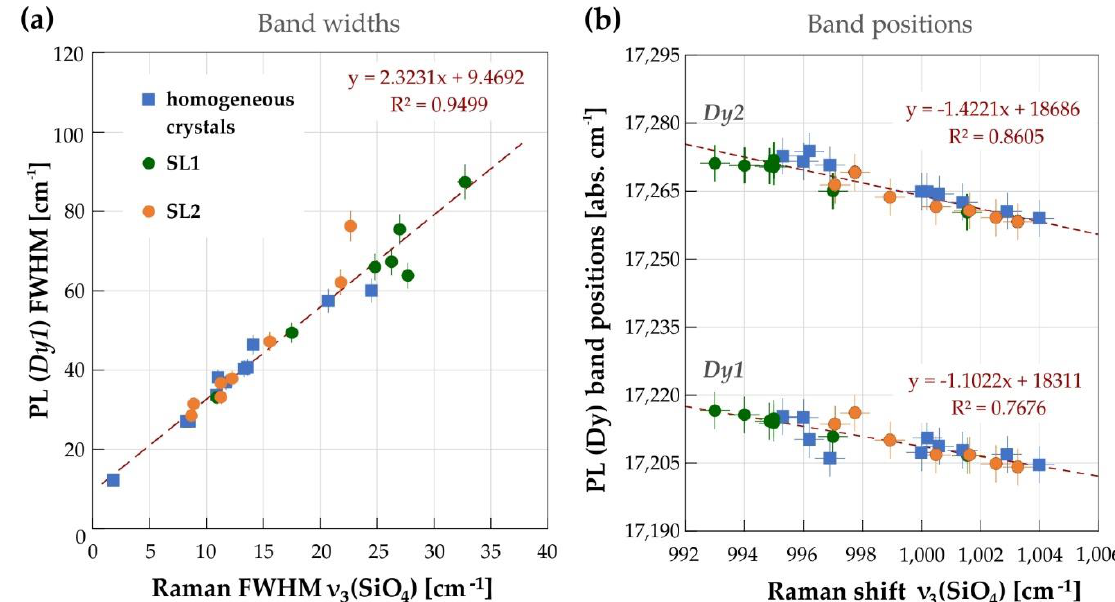
Figure 6. Comparison of spectral parameters of the Raman ν 3 (SiO 4 ) and laser-induced Dy 3 + photoluminescence sublevel-bands of Sri Lankan zircon samples that are characterised by different degrees of radiation-damage accumulation. Measurement points from the unannealed halves of sample SL1 and SL2 are indicated in Figure 4. Photoluminescence sublevel-bands considered here are indicated as Dy1 and Dy2 in Figure 3a. Note, that Dy 3 + sublevel-band parameters were fitted with Gauss-Lorentz functions after subtraction of the ‘amorphous’ broad-band component (cf., Figure 3). ( a ) The band-width of PL sublevel Dy1 closely correlates with that obtained from the Raman ν 3 (SiO 4 ) mode. Both, increasingly broaden with progressive accumulation of structural radiation damage. ( b ) Spectral band positions are inversely correlated. Whereas Raman band ν 3 shifts to lower wavenumbers, PL bands Dy1 and Dy2 shift to higher peak positions with progressive damage accumulation.